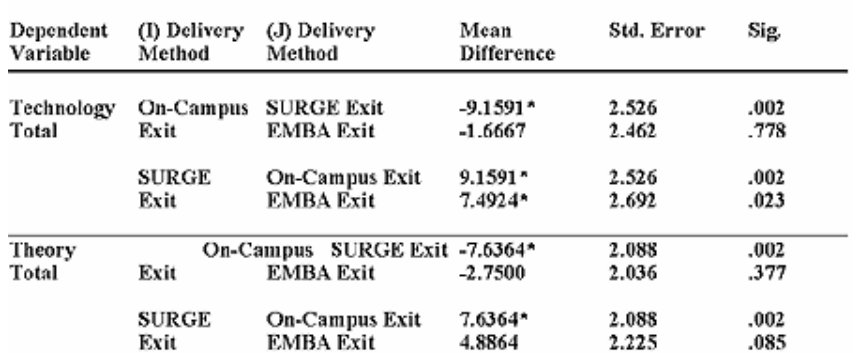
Table 5. Multiple comparisons (Tukey HSD)